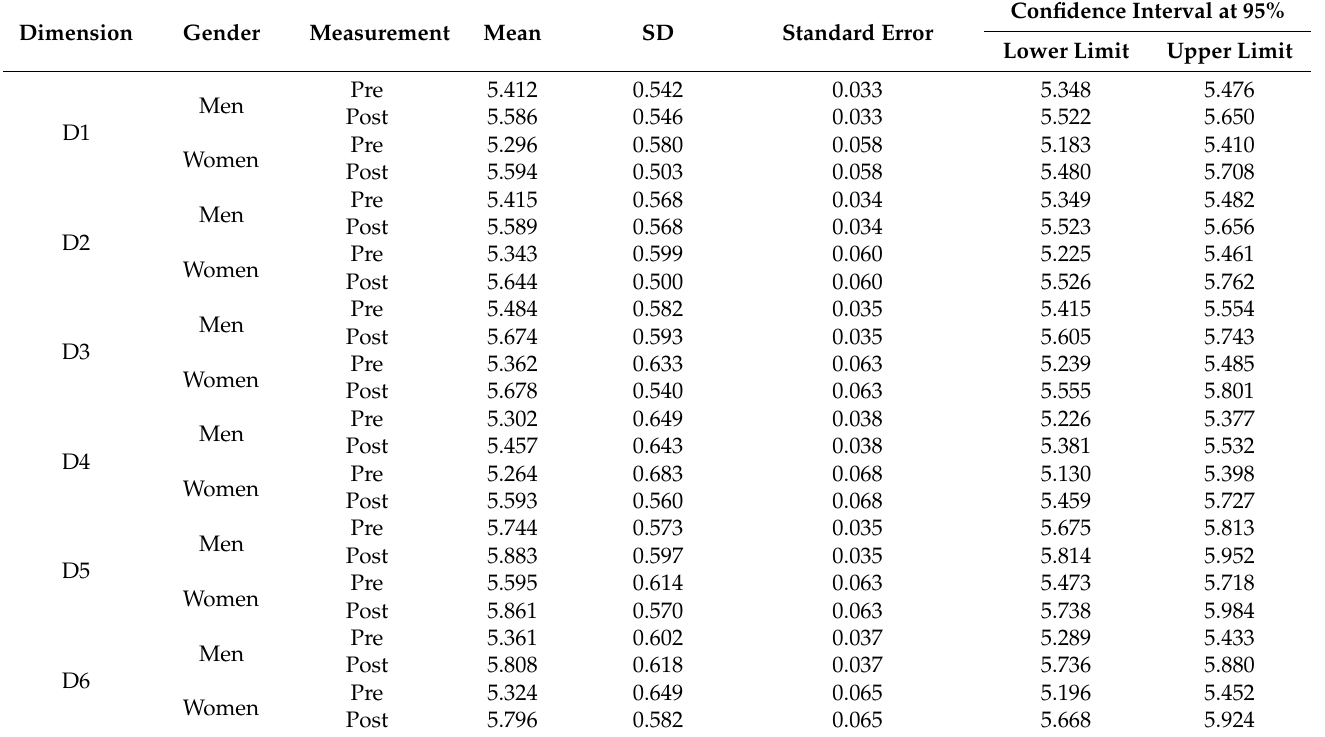
Table 3. Descriptive data of the initial–final measurements vs. gender.